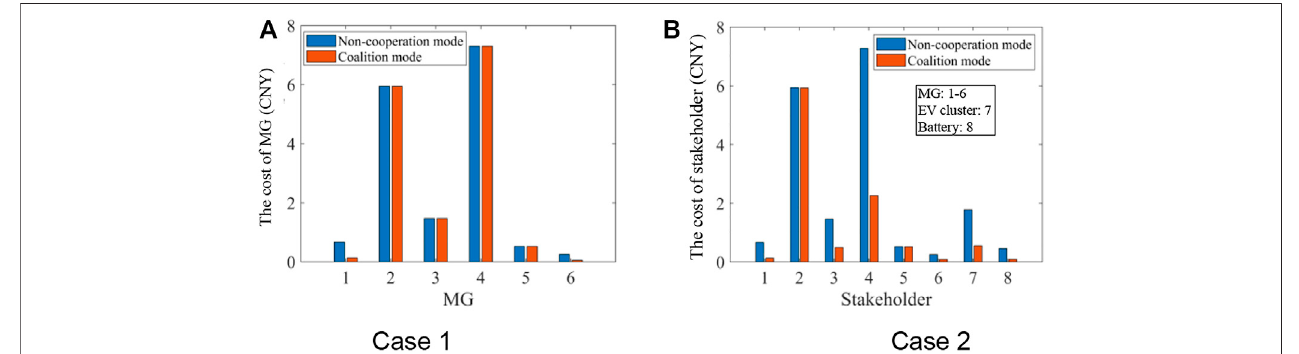
FIGURE 10 | Cost comparison between non-cooperation mode and coalition mode.